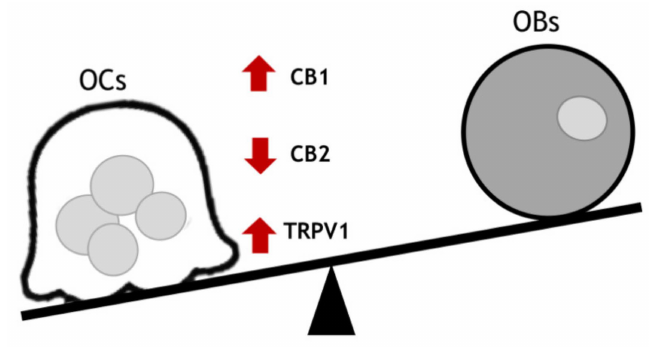
Figure 2. Altered homeostasis in osteoporosis. Activated osteoclasts (OCs) in patients with osteoporosis express low levels of CB2 receptor and high levels of CB1 and TRPV1. CB1 and TRPV1 stimulation activates osteoclasts, while CB2 represents the counterpart for bone mineralization and remodeling via osteoclast inhibition.